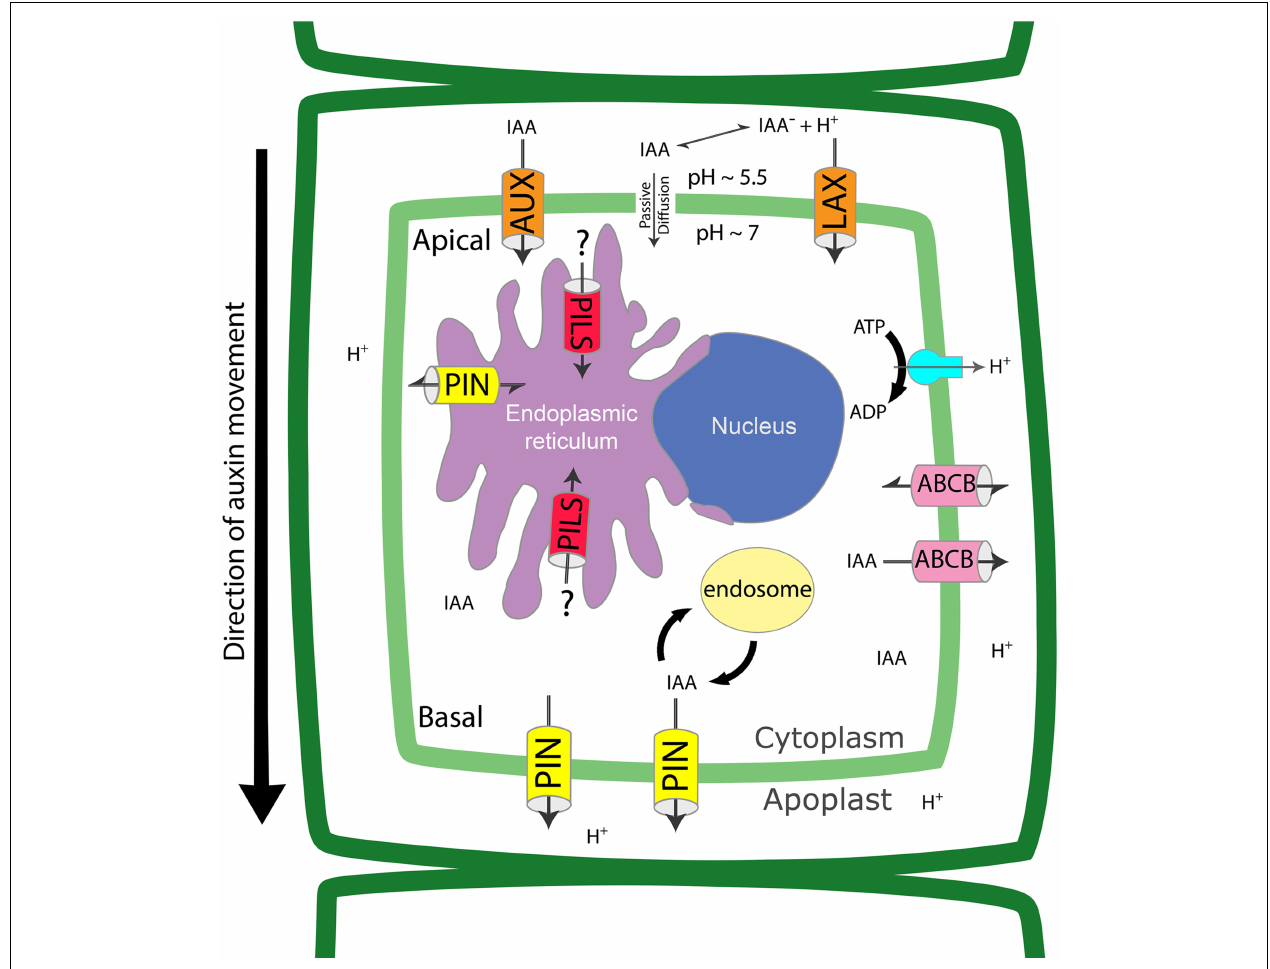
pathway. AUX/LAXs and PILs are influx carriers located at PM and ER, respectively. ABCBs are located at the PM and use energy from ATP to traslocate IAA. The coordinated localization of the different transporters determines the overall directionality of the auxin flux and contributes to the regulation of intracellular auxin